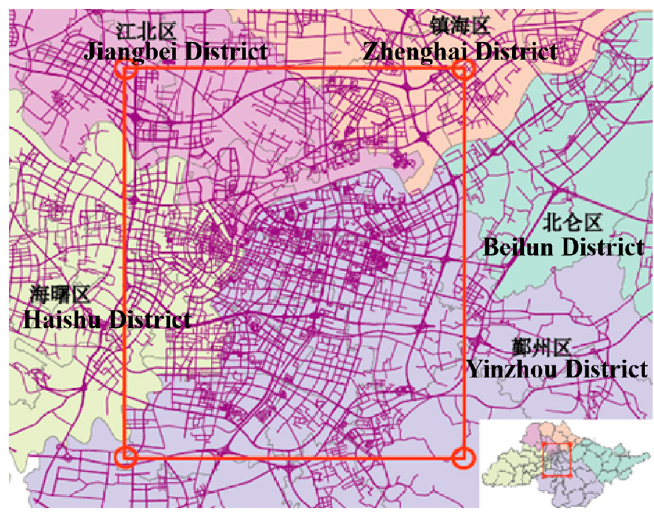
Figure 3. Study area.